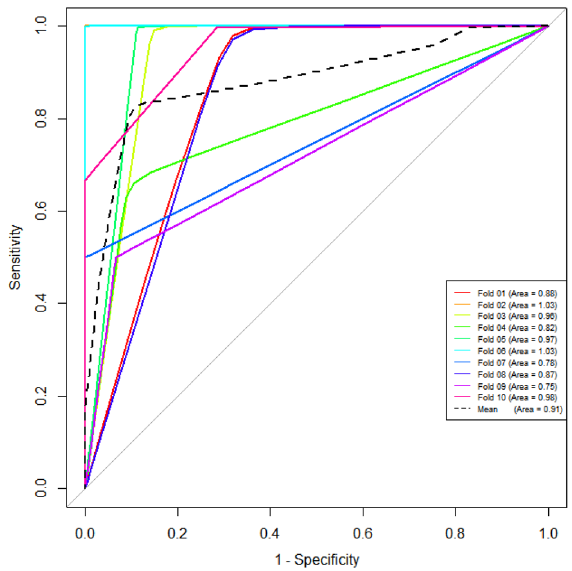
Figure 1. The tenfold cross-validation in the testing set was performed to verify the stability of radiomics-only logistic model. The mean AUC was 0.910, which was similar to the calculated 0.923 in the testing set.